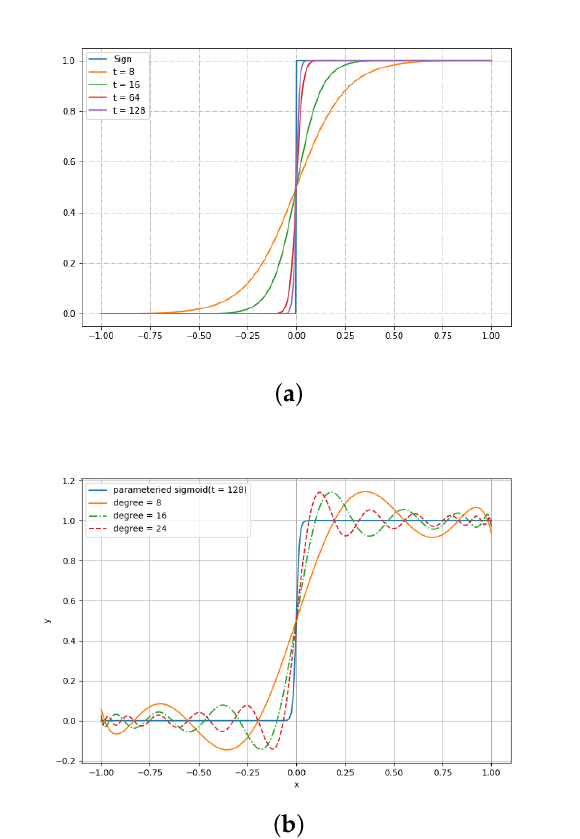
Figure 4. Parameterized sigmoid function and its approximation. ( a ) Parameterized sigmoid function; ( b ) Chebyshev